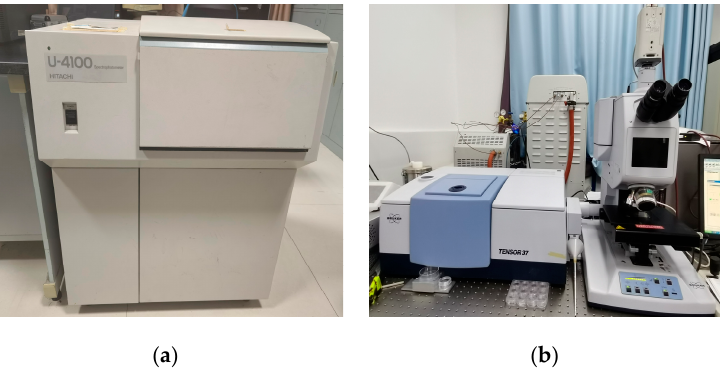
Figure 5. ( a ) U-4100 spectrophotometer; ( b ) BRUKER TENSOR 37 infrared spectrometer.